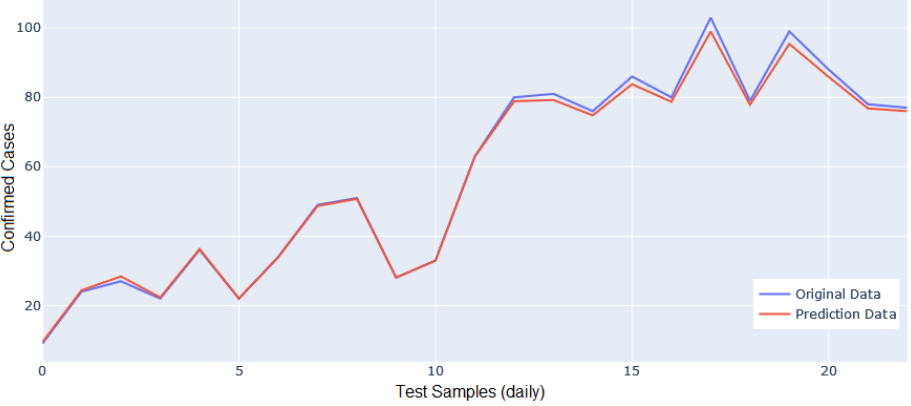
Figure 14. Prediction accuracy comparison between actual and predicted data using indoor dataset